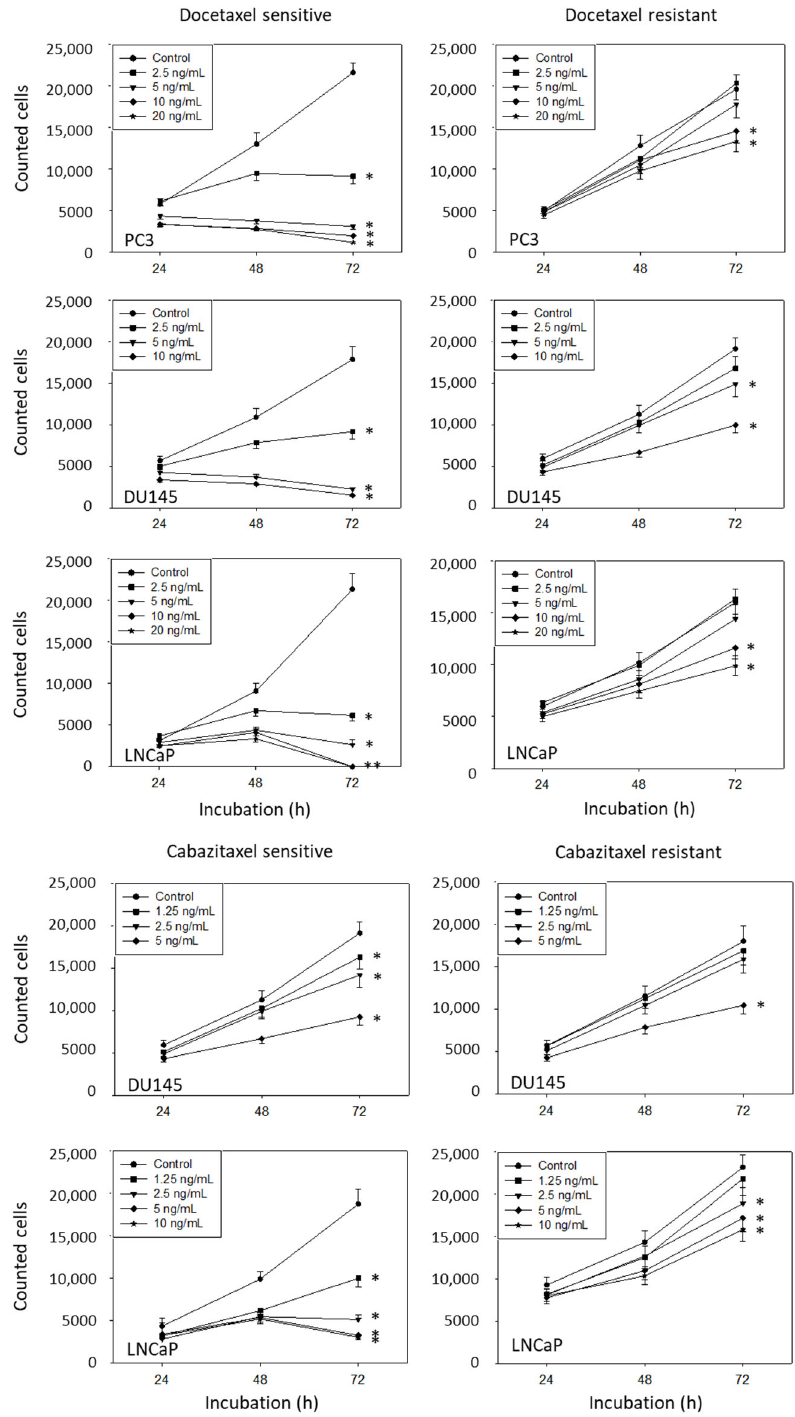
Figure 1. Dose–response analysis of sensitive and drug-resistant prostate cancer cells. Growth of cabazitaxel-sensitive versus cabazitaxel-resistant cells has not been evaluated on PC3 cells. Error bars indicate standard deviation (SD). * indicates significant difference to the corresponding control, n = 5.